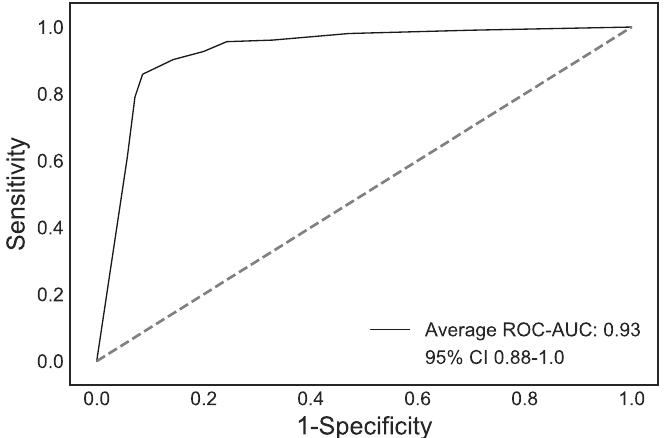
Figure 3. Average ROC curve (black) and 95% confidence interval (CI) (shaded blue) for the five cross-validation folds.